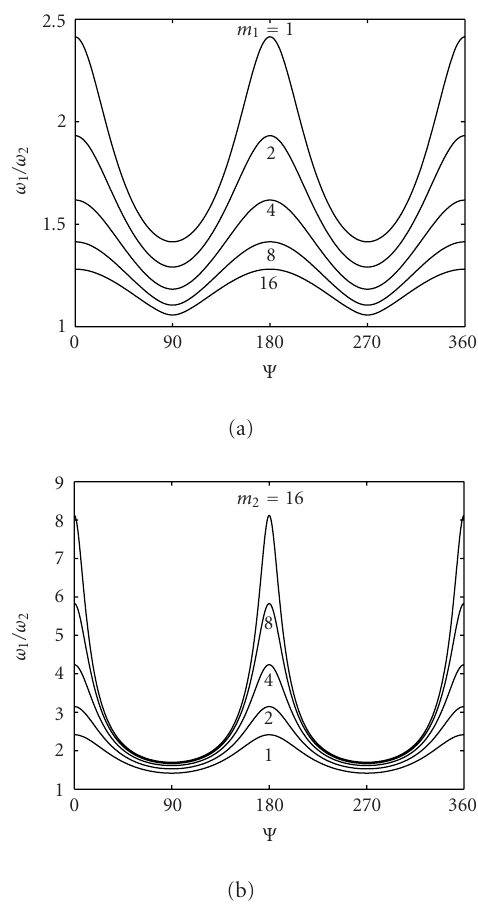
Figure 4.7. Comparison between values of the point mass for the first (a) and second (b) pendulums of SDP. The normalized initial parameters are shown on the